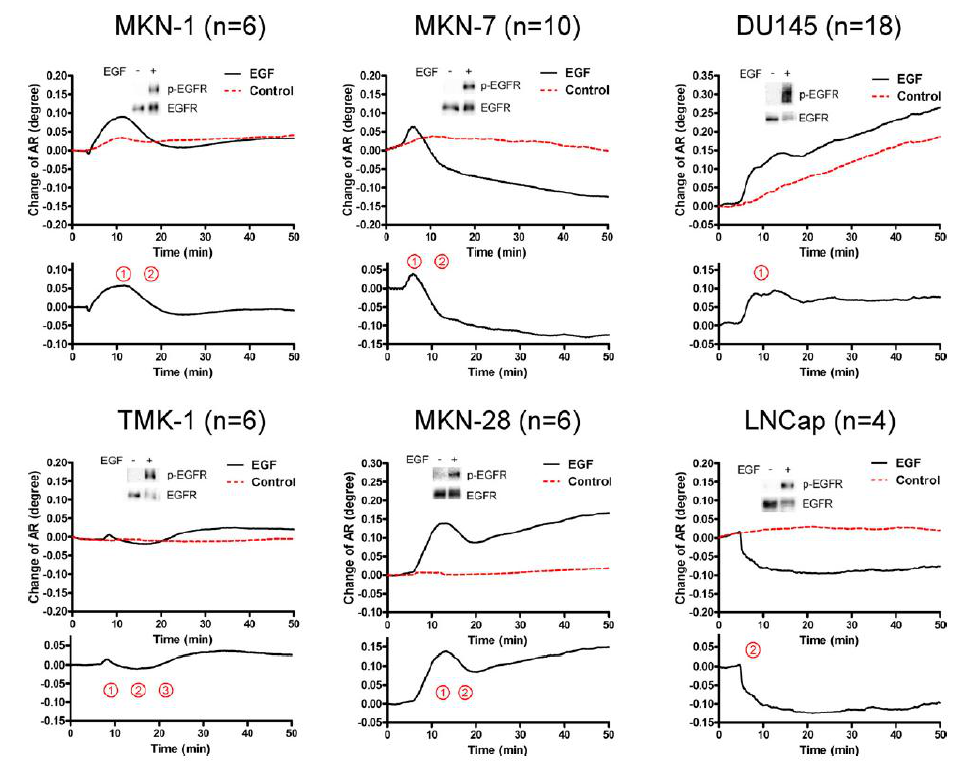
Figure 3. SPR signals (change of angle of resonance (AR)) in six cell lines established from different cancers. TMK-1 cells showed weak, but complete, triphasic changes of AR, whereas the other five cell lines showed unique incomplete patterns of SPR